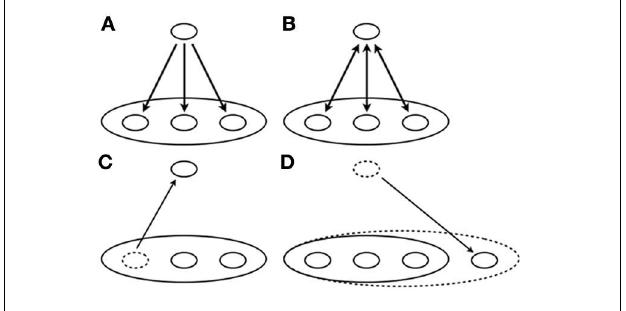
FIGURE 2 | Schematic diagram of (A) hierarchy, (B) heterarchy, (C) observational heterarchy with compression effect, and (D) observational heterarchy with extension